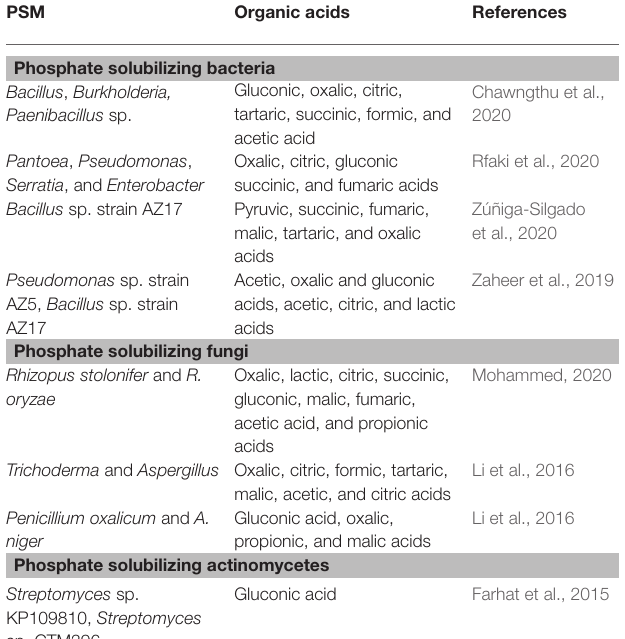
TABLE 2 | Organic acids secreted by